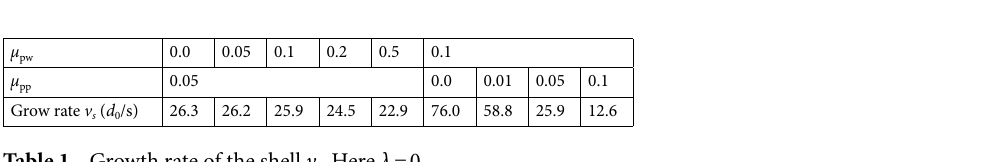
Figure 3. ( a ) Development of averaged shell surface height ( between v p and v s . ( c ) Log–log plot of the slope of the linear relationship presented in Fig. 4b. Here λ = 0.